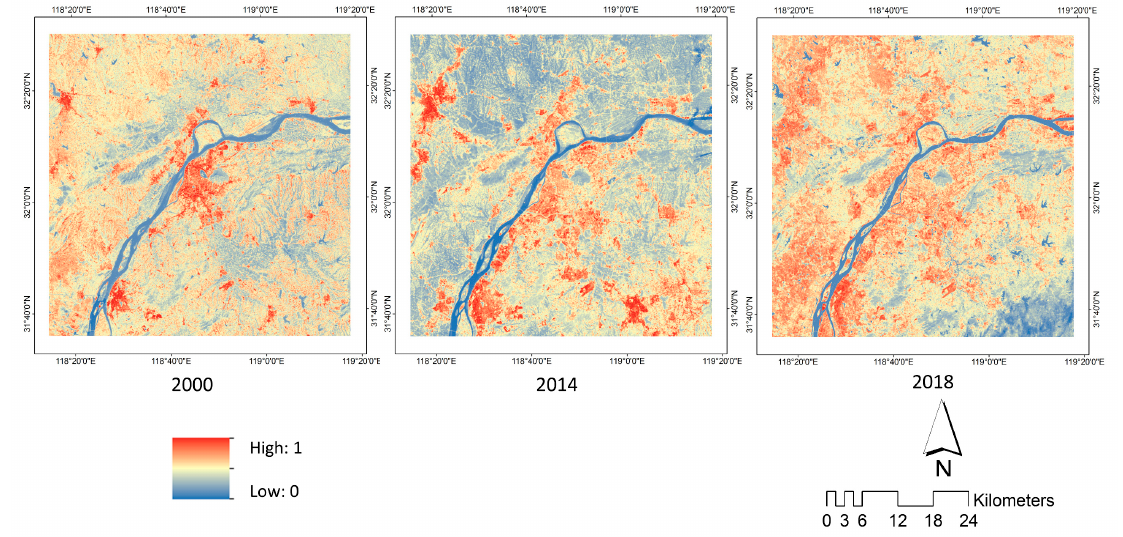
Figure 6. Land surface temperature (LST) maps of Nanjing in 2000, 2014, and 2018.